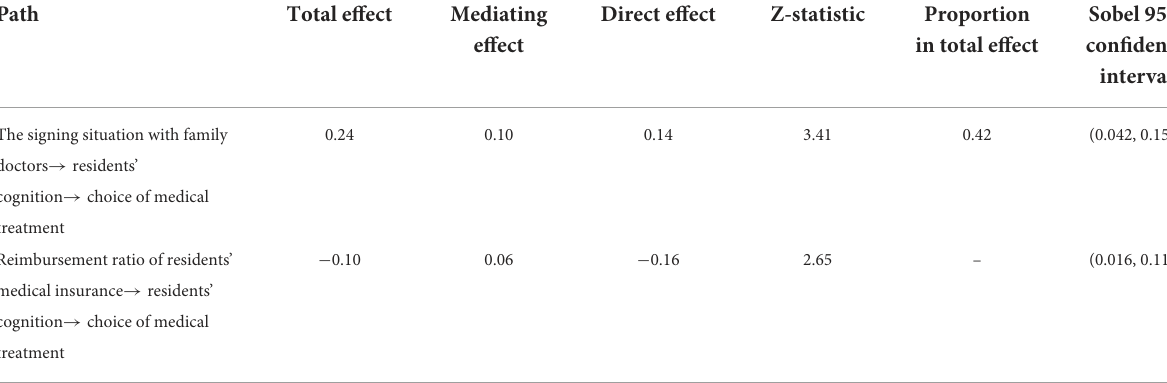
TABLE 6 Sobel mediating effect test results of residents’ cognition